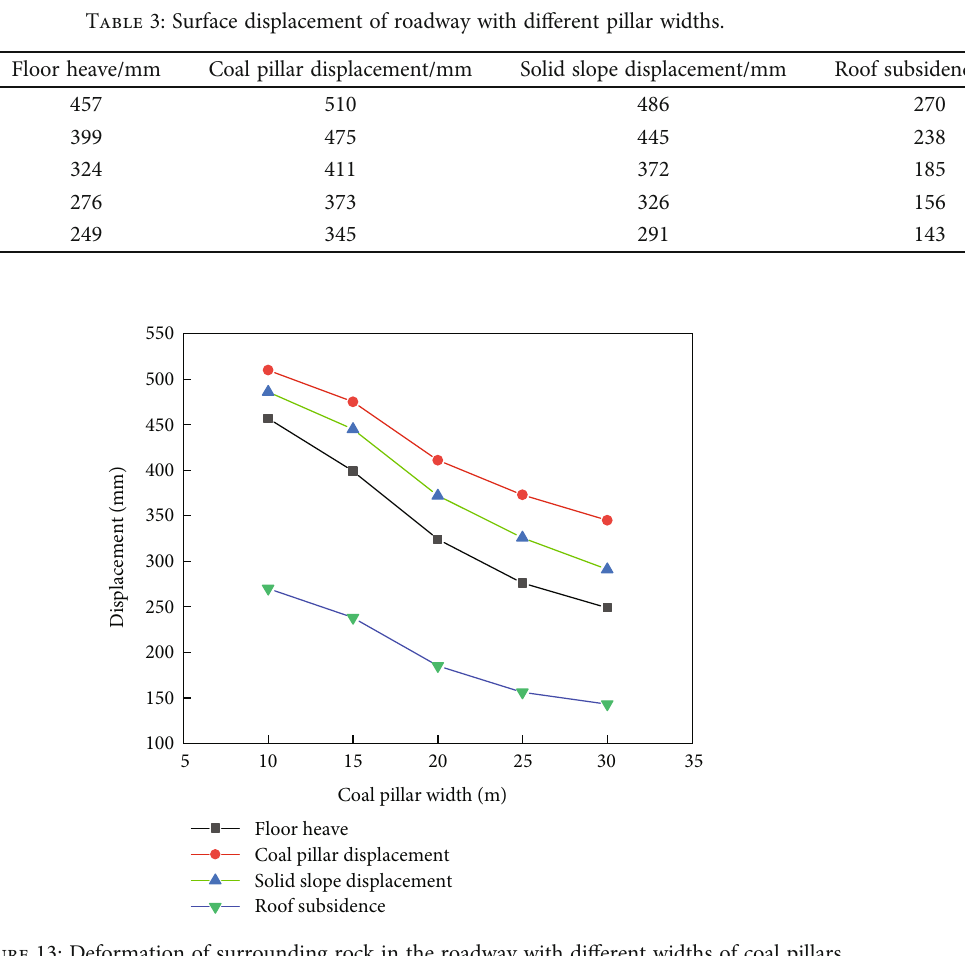
Figure 13: Deformation of surrounding rock in the roadway with di ff erent widths of coal